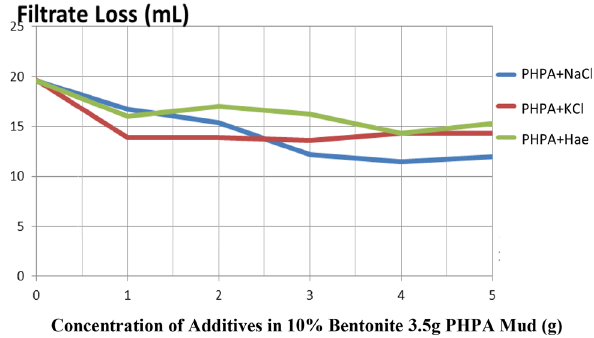
Fig. 20 Effect of NaCl, KCl and haematite on filtrate loss of PHPA– bentonite mud